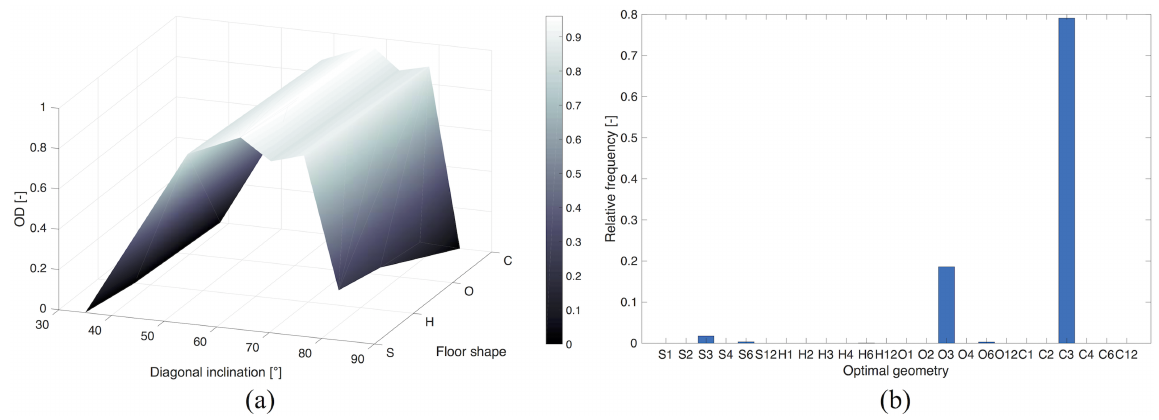
Figure 6: Results for the 126-meter tall building: (a) surface representation of the OD with respect to the diagrid geometrical parameters obtained with r δ = r ϕ = r M = r CI = 1.00 ; (b) optimal diagrid geometry based on 4096 simulations with different exponents r p